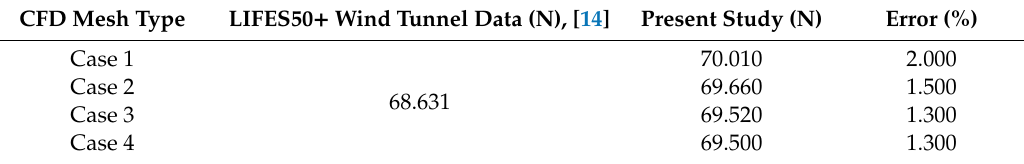
Table 3. Comparison of thrust between experiment and CFD simulation at di ff erent grid densities.